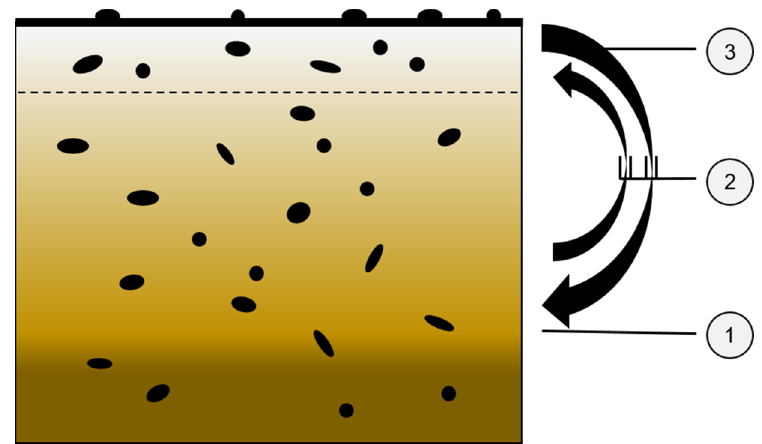
Figure 2. Illustration of three properties assigned to objects in the tillage class. These relate to (1) the depth of tillage, (2) degree of mixing or soil inversion and (3) intensity of tillage (width of the arrow). Objects that differ in these properties will act differentially on the distribution of weed seeds between the soil layers: surface, shallow and deep.